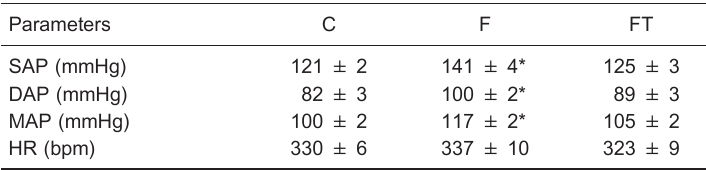
Table 2. Cardiac hemodynamic measurements in sedentary control (C), sedentary fructose (F) and trained fructose (FT)